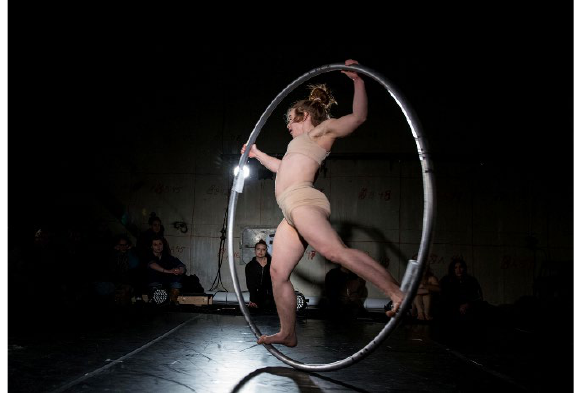
Figure 9. The acrobat in action (Case